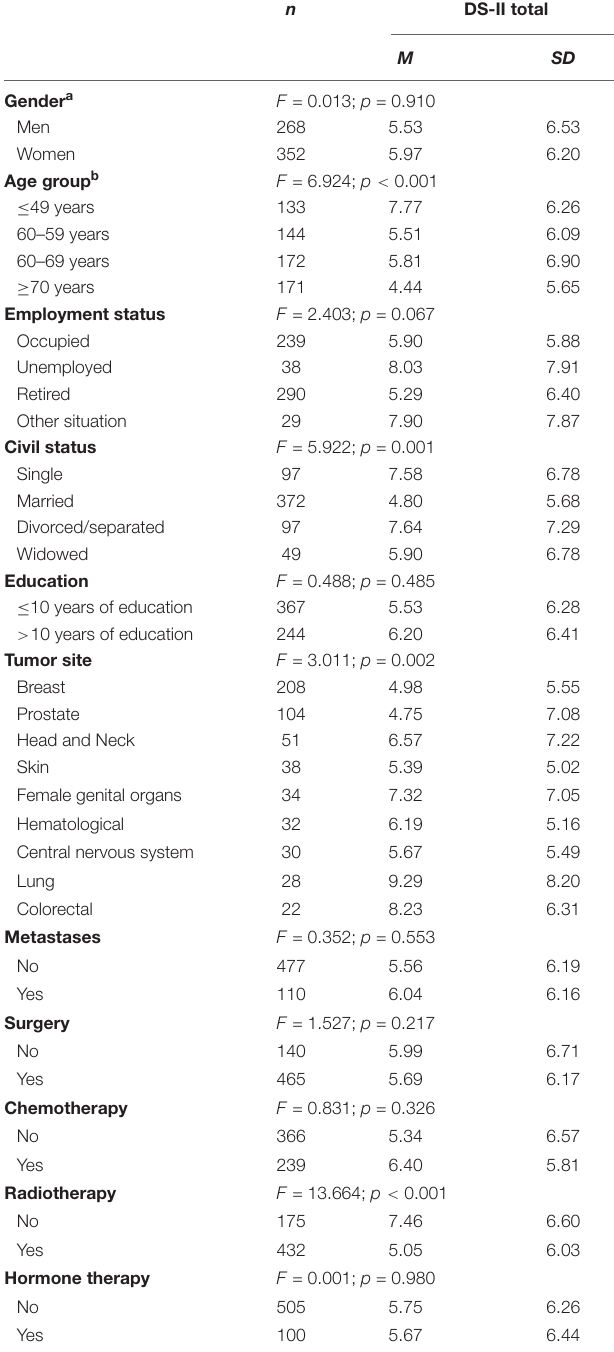
TABLE 5 | Demoralization Scale-II mean scores depending on sociodemographic, disease- and treatment-related